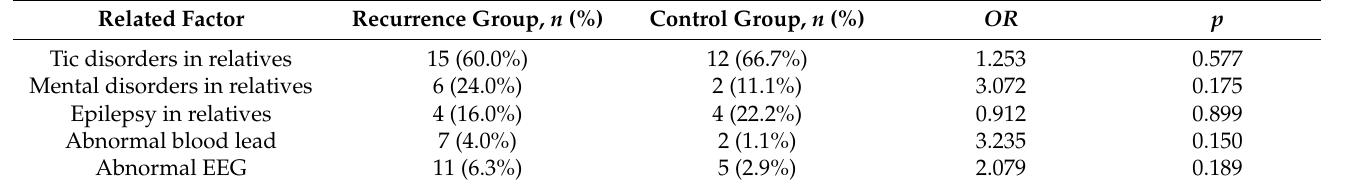
Table 4. Correlations between family medical history, blood lead, EEG, and tic recurrence (modifiable factor).